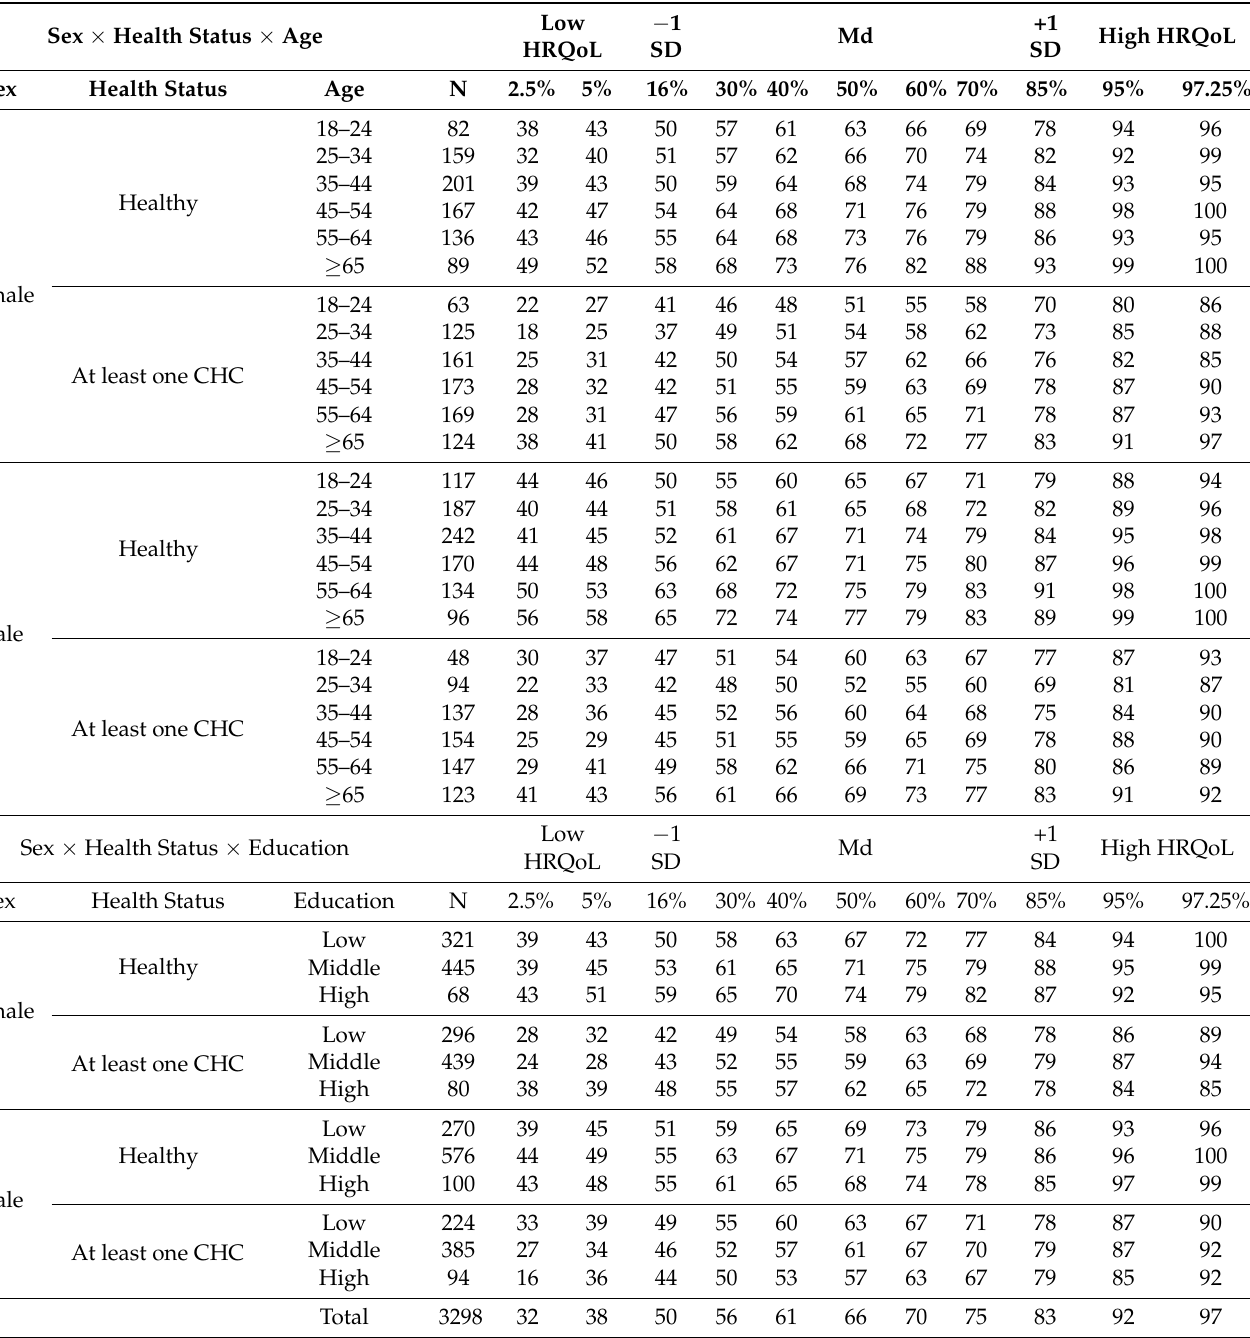
Table 8. Reference values for the QOLIBRI total score obtained from the general population sample in Italy stratified by sex, health status, age, and